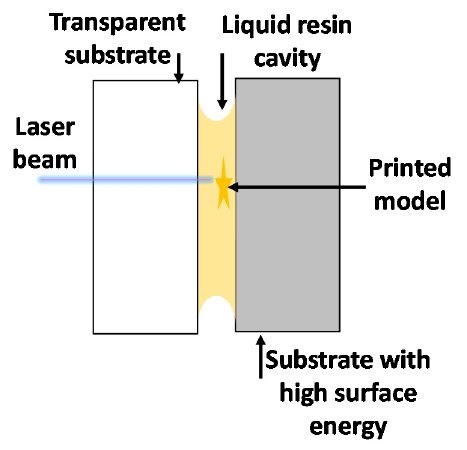
Figure 9. View of liquid bridge microstereolithography (LBMSL) setup.